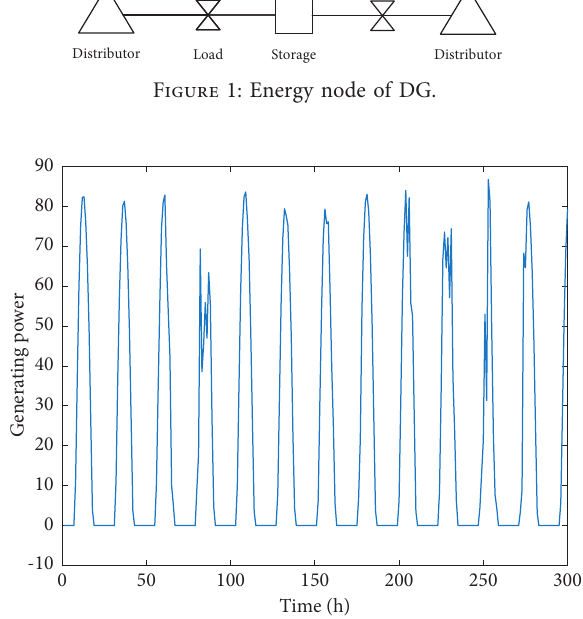
Figure 2: Solar energy